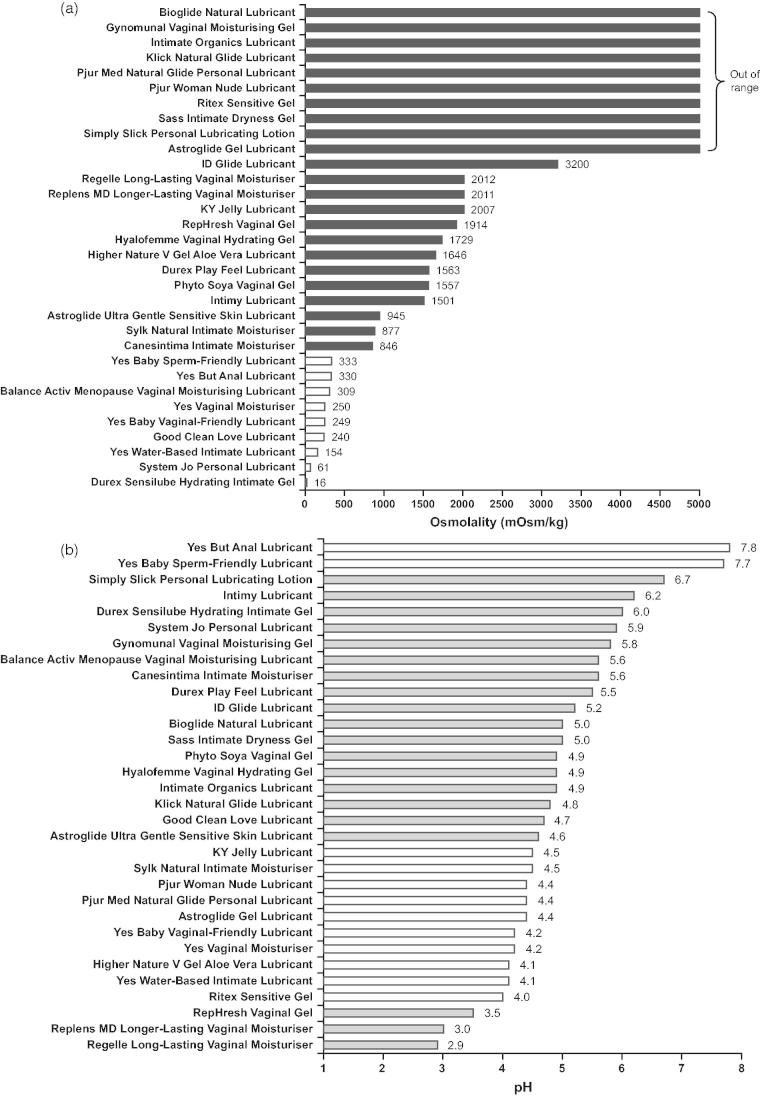
Osmolality (a) and pH (b) of a panel of personal lubricants and moisturizers available world-wide. Black bars represent hyperosmolar preparations that exceed the ideal osmolality threshold of 380 mOsm/kg recommended by the World Health Organization for a personal lubricant (most of which also exceed the real-world recommended threshold of 1200 mOsm/kg)30, and which therefore have the potential to cause irritation and/or damage to vaginal or rectal mucosa. In healthy adults, normal vaginal and rectal pH ranges are 3.8–4.5 and ∼7.0, respectively30. Gray bars represent preparations that are considered outside of these thresholds. Osmolality and pH testing methods are described in the online Supplemental Material S1 (http://dx.doi.org/10.3109/13697137.2015.1124259).